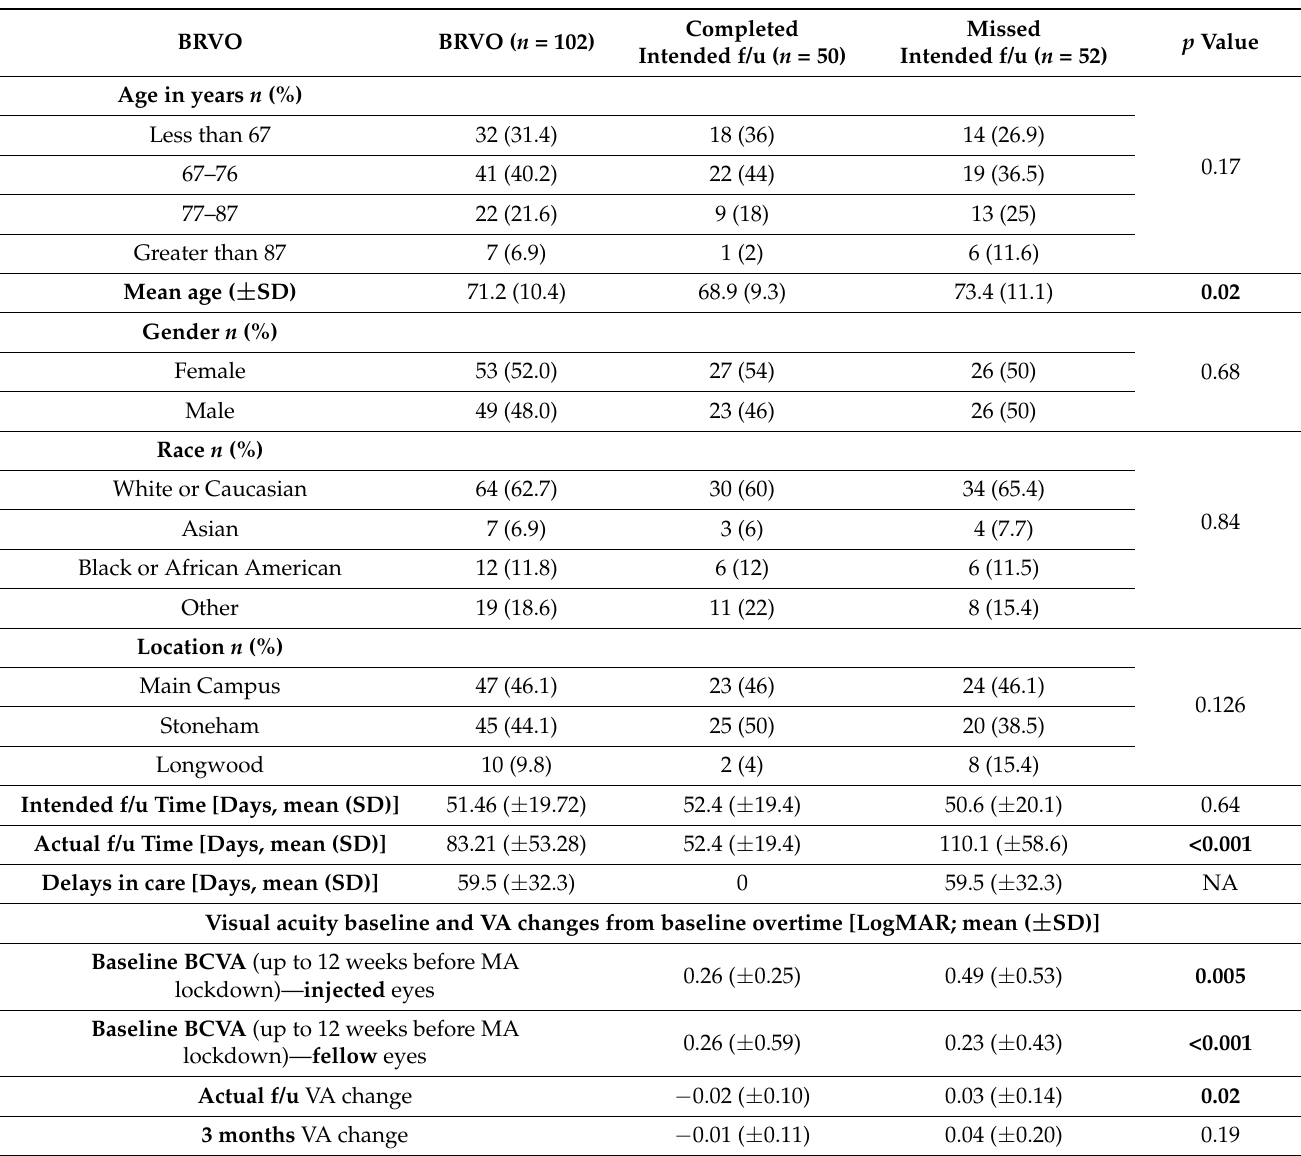
Table 5. Demographic and clinical characteristics of BRVO